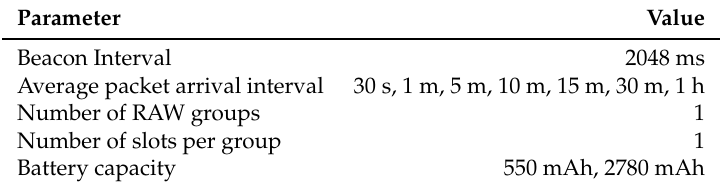
Table 9. Configuration for the comparison of energy consumption using target wake time